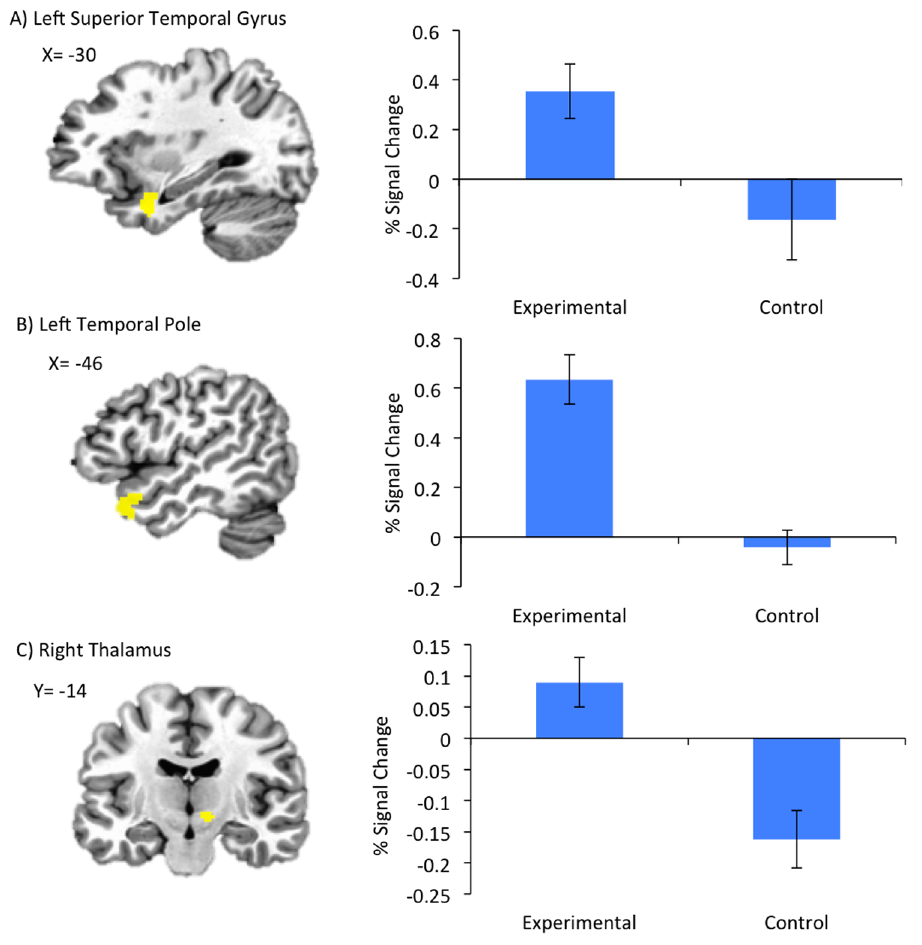
Figure 4. Group differences in BOLD activity during the Transfer Run. Regions A) Left Superior Temporal Gyrus B) Left Temporal Pole C) Right Thalamus and associated percent signal change graphs, are shown where groups had differential activation during Happy AM recall vs Rest during the Transfer run in which no neurofeedback was provided. Error bars indicate + /1 one standard deviation of the mean.